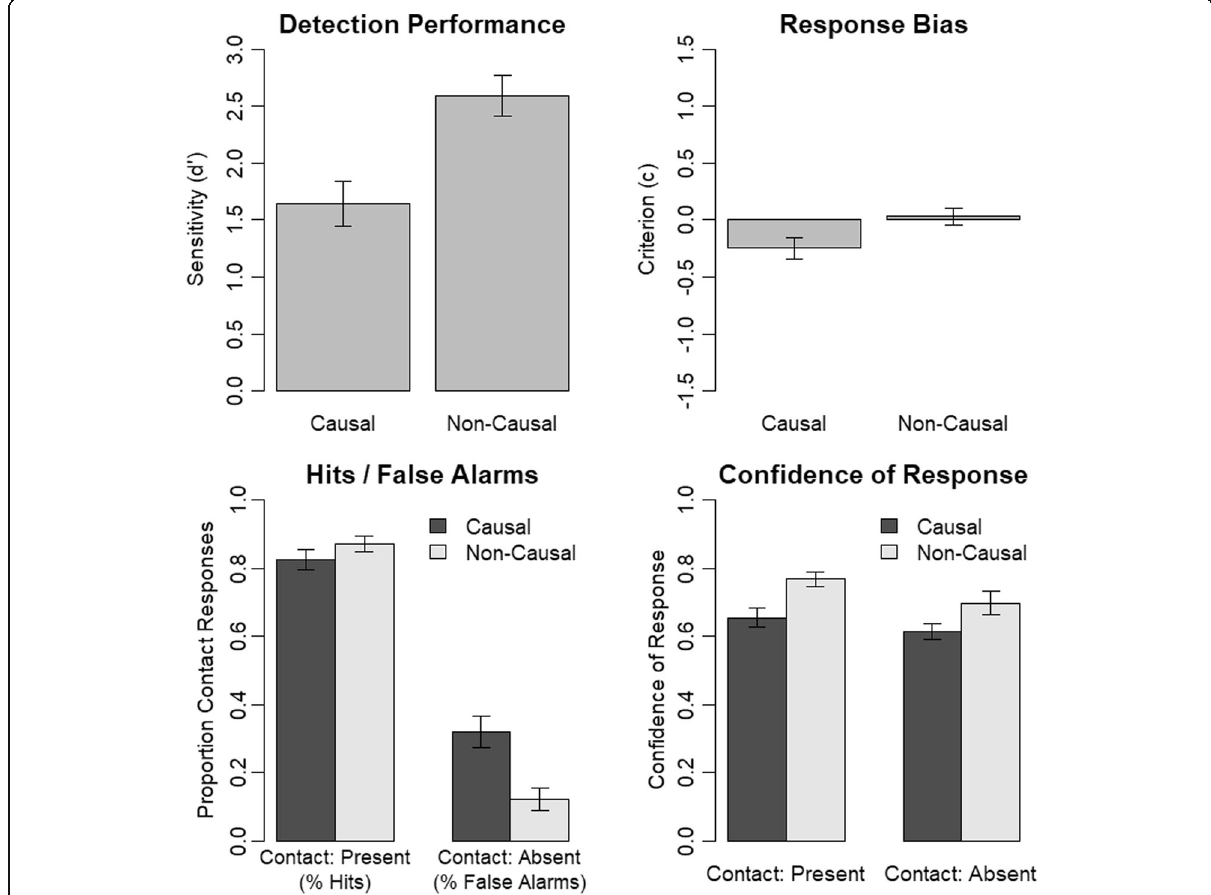
Fig. 3 Results of Experiment 1 (delayed-response experimental version). Error bars indicate the standard error of the